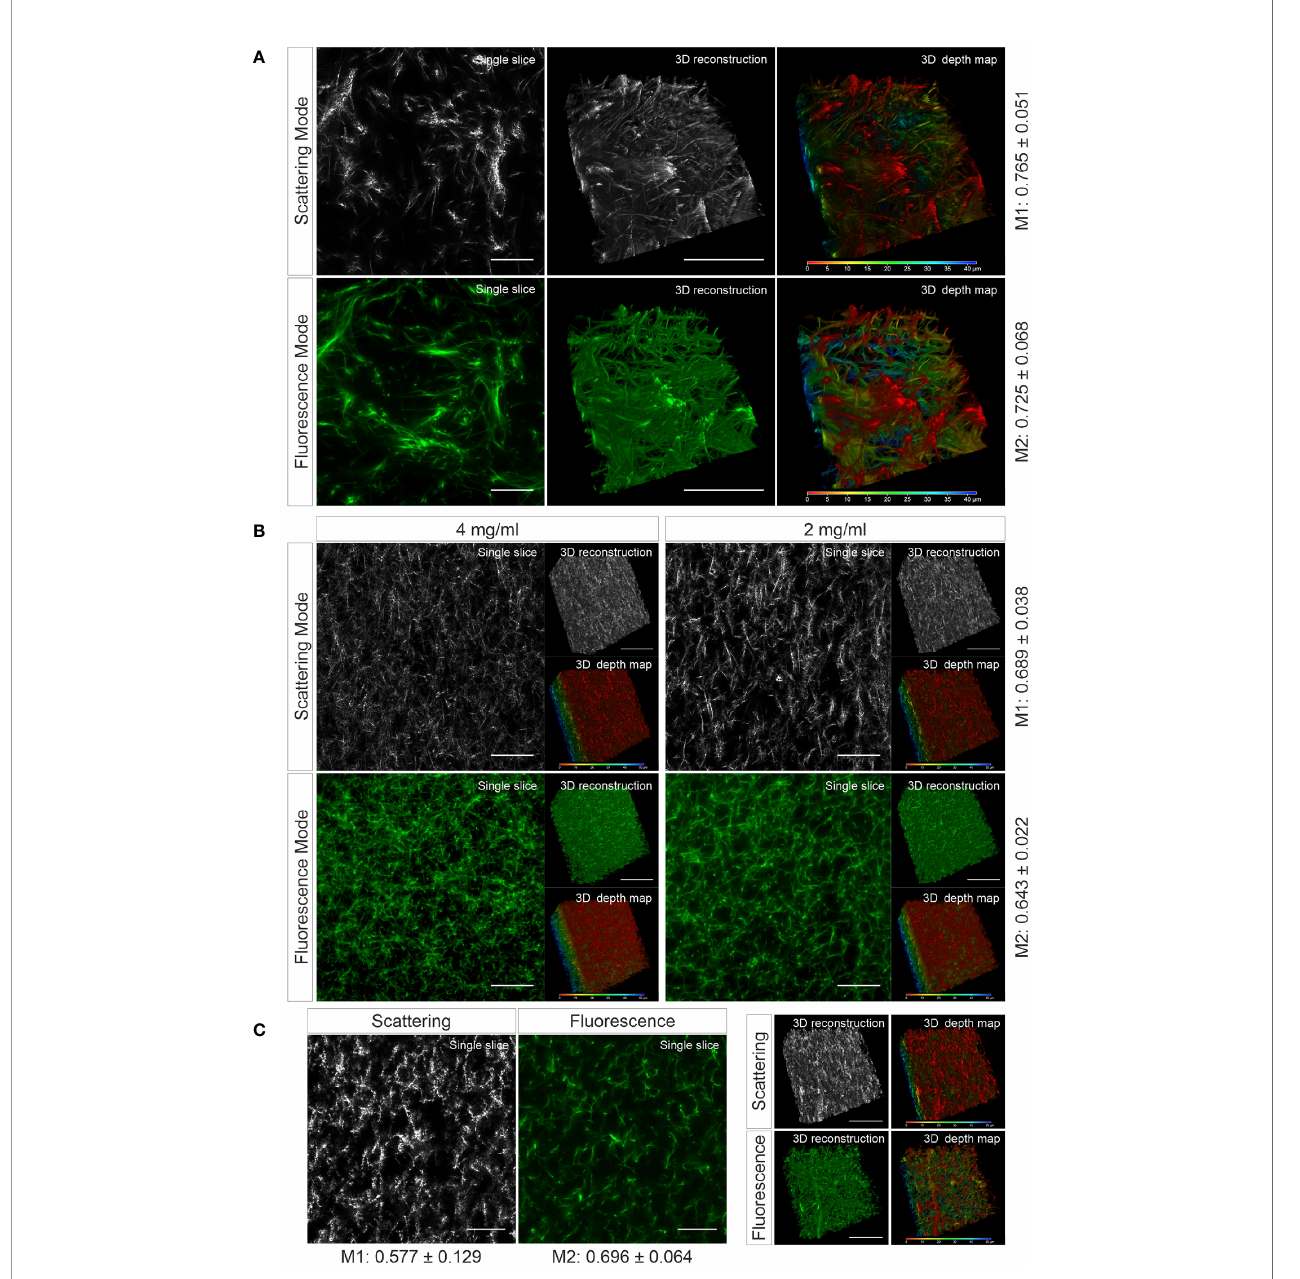
FIGURE 1 | Collagen structures visualized by LSSM. Collagen from human (A) , (2mg/ml), bovine (B) , (2 and 4 mg/ml) or rat tail (C) , (2mg/ml) was used. Collagen was fl uorescently labeled with Atto 488. Z-stacks with step-size of 0.4 µm for 95 slices (A) or for 119 slices (B, C) were acquired. Scale bars are 40 m m. Representative images from at least three independent experiments are shown. Mander ’ s coef fi cients (M1: scattering over fl uorescence, M2: fl uorescence over scattering) were quanti fi ed from 3 (A) or 4 (B, C) independent